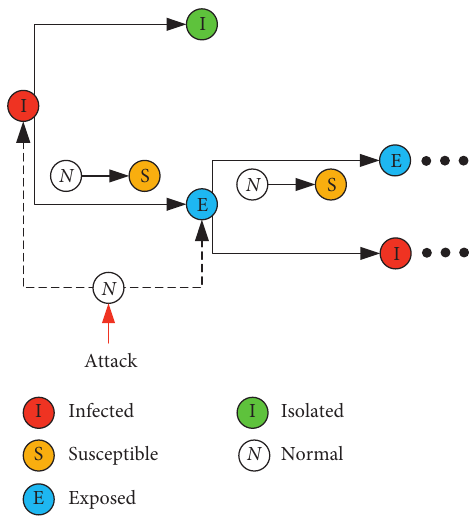
Figure 2: The devices state transition under